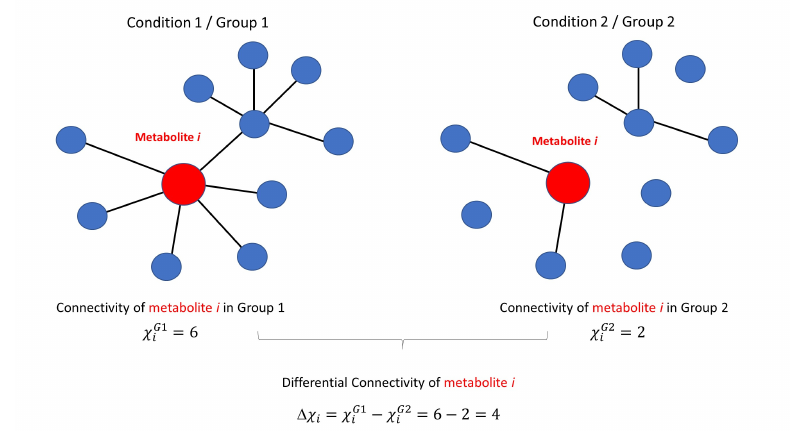
Figure 1. Graphical illustration of the concept of metabolite connectivity and differential connectivity. An ideal unweighted metabolite-metabolite association network involving 10 metabolites is shown under two different conditions. Metabolite i is connected with a different number of metabolites (represented by the existence of an edge ) in the two conditions. The connectivity χ i of metabolite i is given by the number of connecting edges (for a generalisation for weighted association networks, see Equation (28) in Section 3.3): 6 under condition 1 and 2 under condition 2. The